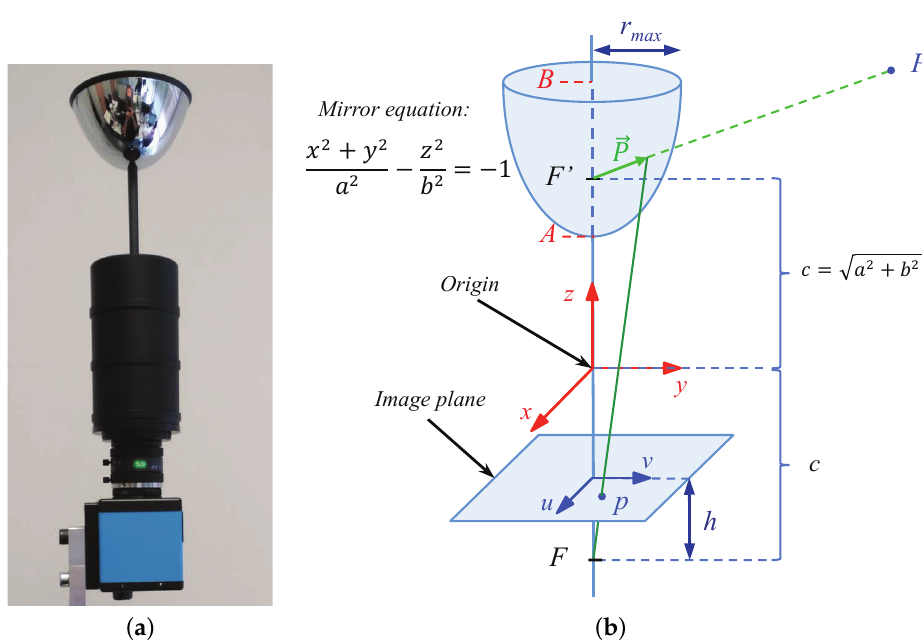
Figure 9. ( a ) Omnidirectional acquisition system. ( b ) Model of the virtual hyperbolic mirror used to capture the synthetic omnidirectional